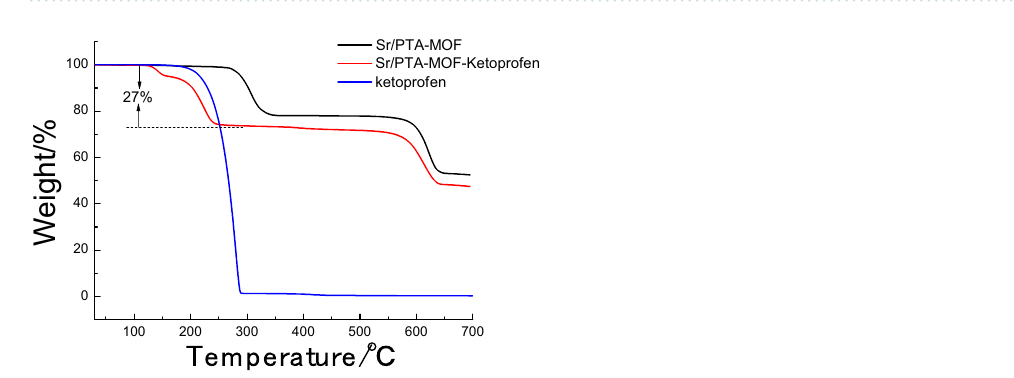
Figure 4. The thermogravimetric (TG) analysis of Sr/PTA-MOF before and after loading